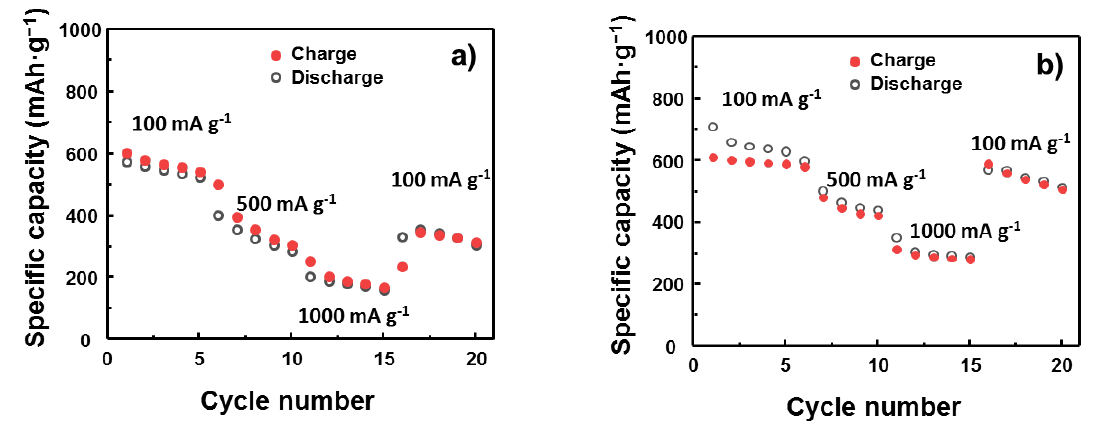
Figure 8. Rate cycling performance of ( a ) bare SnO 2 electrode and ( b ) M1SnO 2 electrode at different current rates.